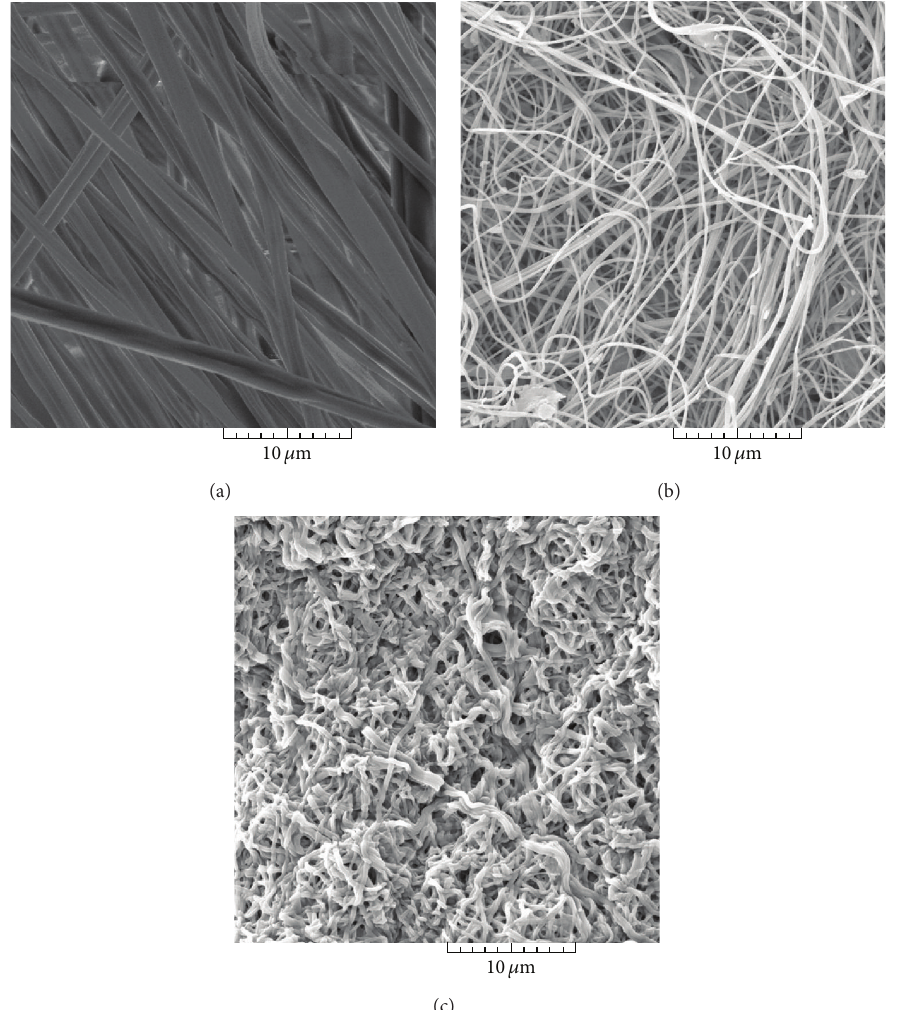
Figure 1: The SEM of the morphological surface structure of CDA (a) and CTS in the polycationic (b) and the polybasic (c) form.